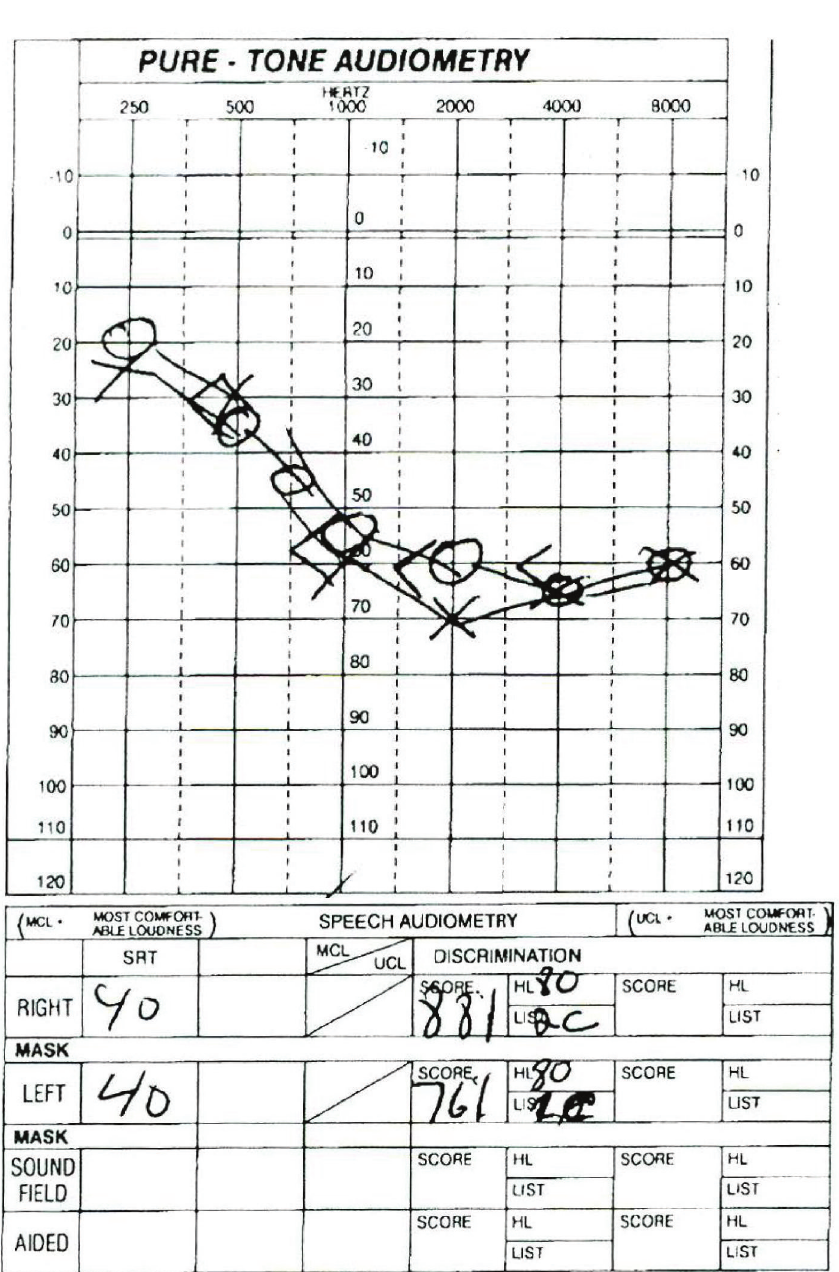
Figure 2: Audiometry graph two months after